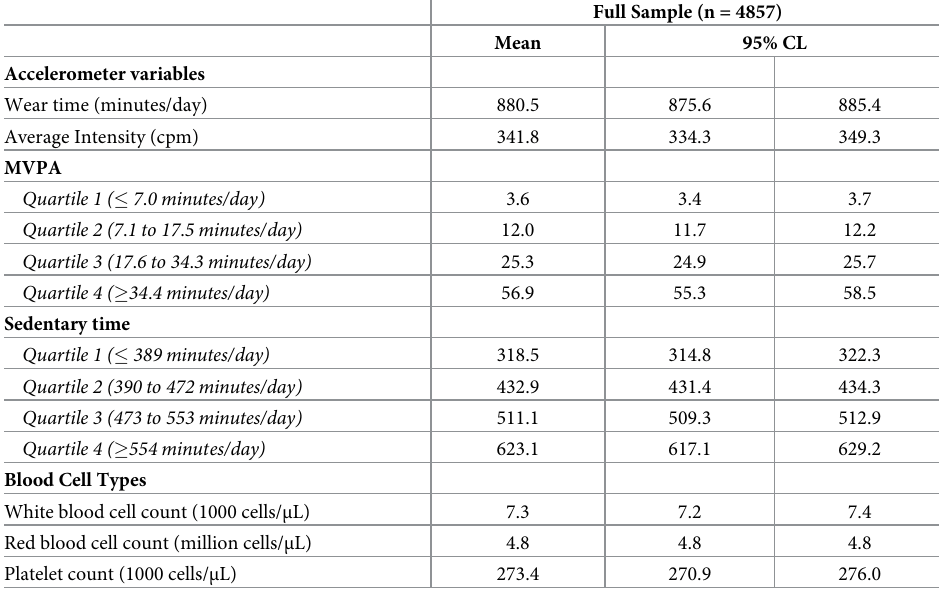
Table 4. This significant inverse association of MVPA and WBCs was also observed using the 760 cpm cut point for MVPA (S2 Table)